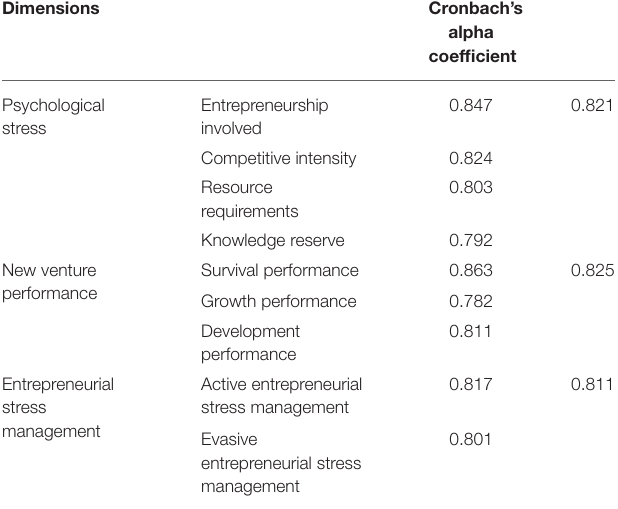
TABLE 4 | Reliability analysis of the scale.